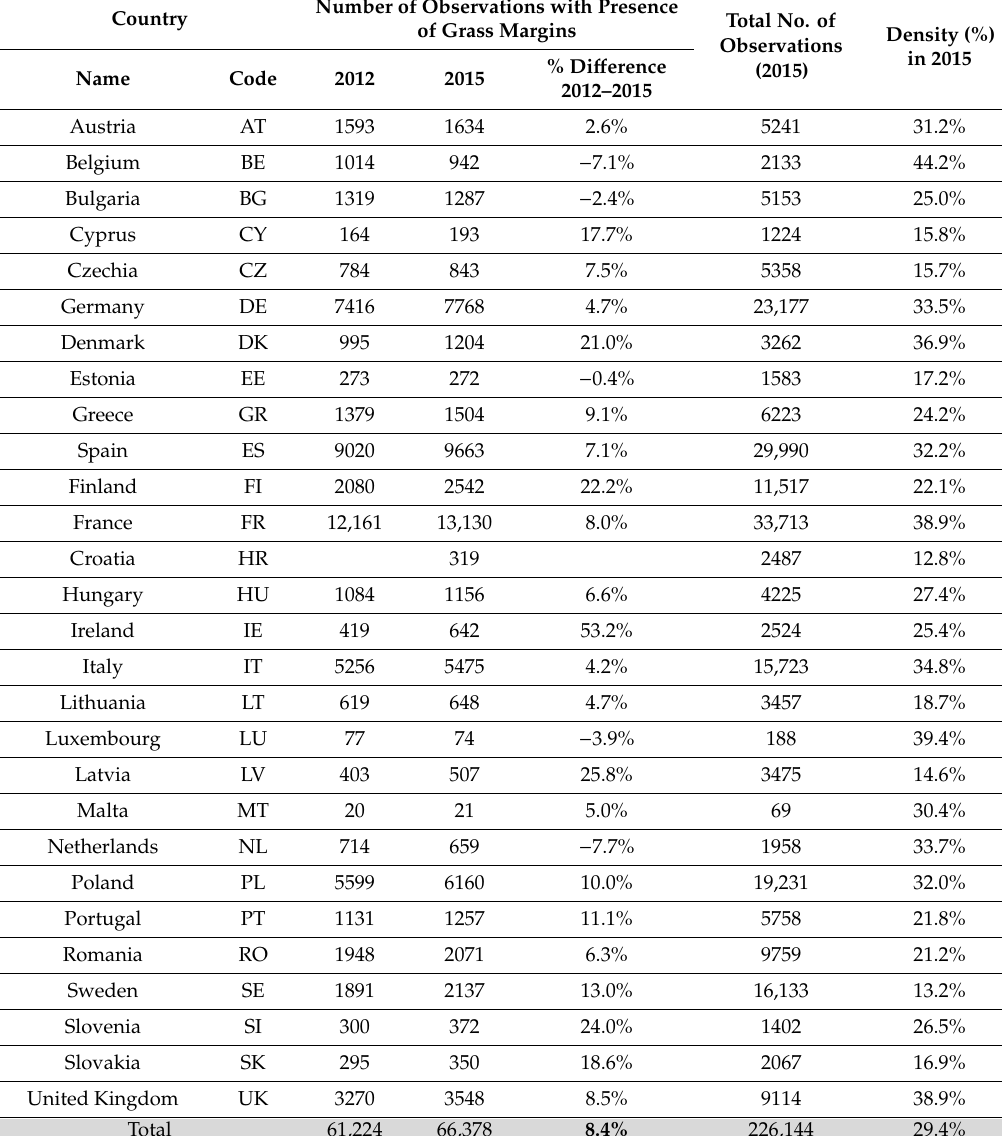
Table 1. Comparison of grass margins in the EU according to the LUCAS survey in 2012 and 2015.